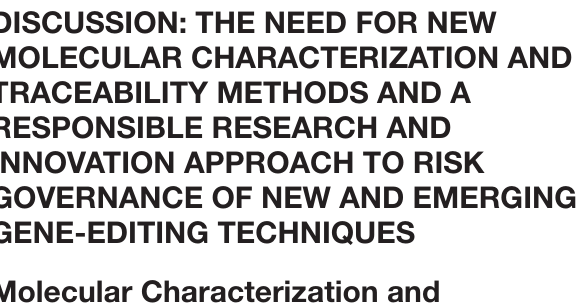
FIGURE 4 | Schematic representation of the different approaches to test for unintended changes in the genome of a gene-editing organism. In the center is the proposed ‘ in vivo testing approach’ by both whole genome sequencing (WGS) and ‘omics’ techniques for the assessment of off-target effects in the recipient’s